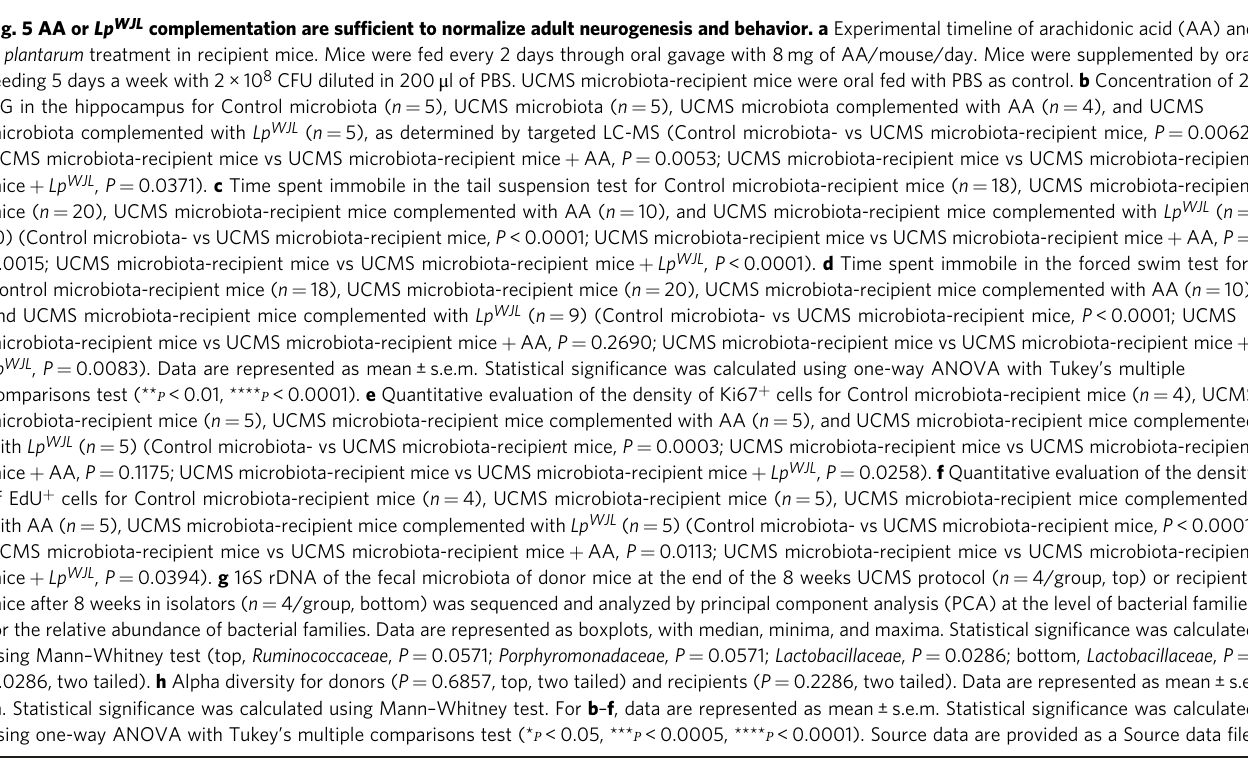
Fig. 5 AA or Lp WJL complementation are suf fi cient to normalize adult neurogenesis and behavior. a Experimental timeline of arachidonic acid (AA) and L. plantarum treatment in recipient mice. Mice were fed every 2 days through oral gavage with 8 mg of AA/mouse/day. Mice were supplemented by oral feeding 5 days a week with 2 × 10 8 CFU diluted in 200 μ l of PBS. UCMS microbiota-recipient mice were oral fed with PBS as control. b Concentration of 2- AG in the hippocampus for Control microbiota ( n = 5), UCMS microbiota ( n = 5), UCMS microbiota complemented with AA ( n = 4), and UCMS microbiota complemented with Lp WJL ( n = 5), as determined by targeted LC-MS (Control microbiota- vs UCMS microbiota-recipient mice, P =